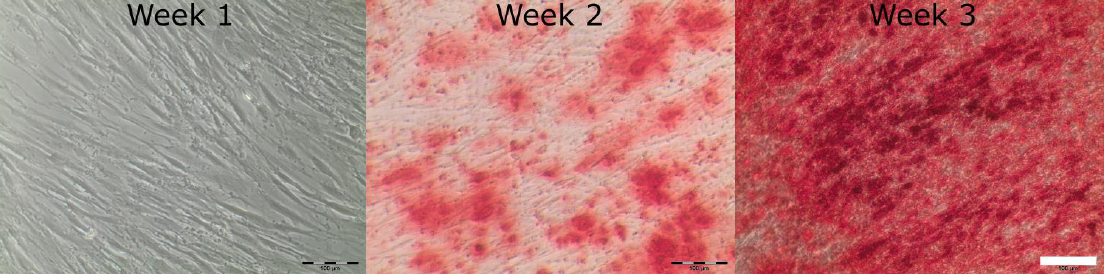
Figure A2. Osteogenic differentiation of 2D-cultivated AD-MSCs. The cells were stained with Alizarin Red 7, 14, and 21 days after induction of the osteogenic differentiation; 10× objective, scale bar 100 µm.